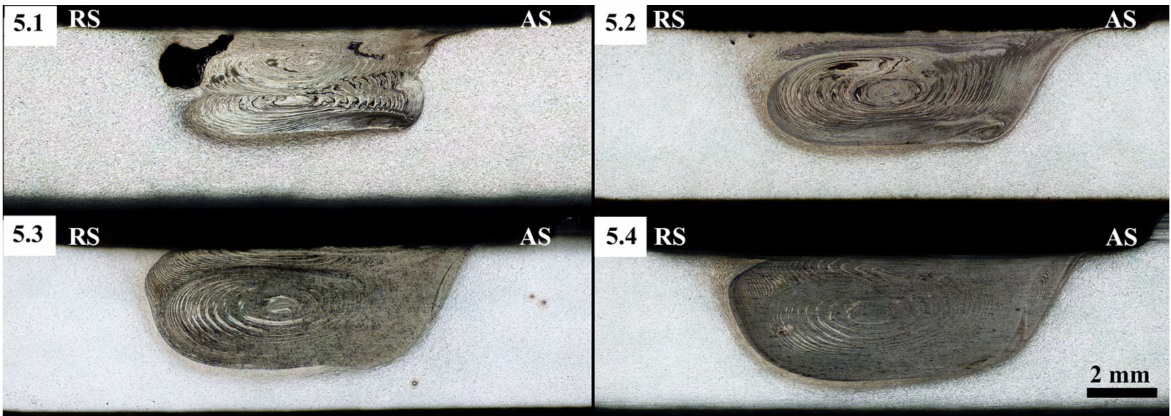
Figure 2. Al-Mg-Sc alloy macrostructure after FSP with 5 wt% Mo after 1–4 passes (samples 5.1–5.4). AS—advancing side, RS—retreating